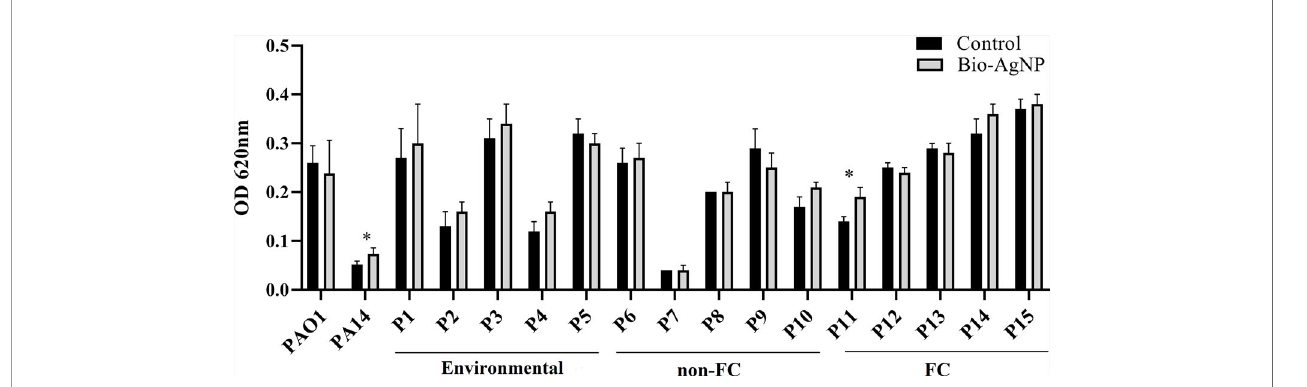
FIGURE 4 | Bio fi lm formation capacity of reference strains, environmental isolates, and clinical isolates of Pseudomonas aeruginosa in the absence (control) and presence of biogenic silver nanoparticles (bio-AgNPs). Results are the mean ± standard deviation of three independent experiments. * p < 0.05 compared with